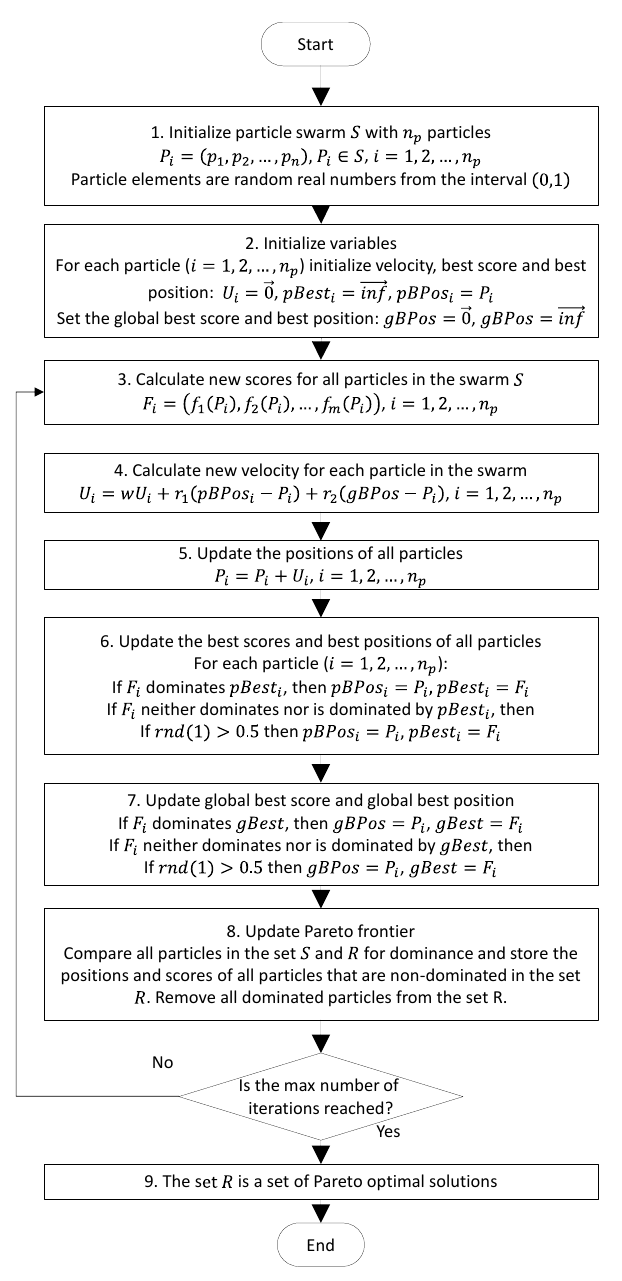
Figure 5. A flowchart of the multi-objective particle swarm optimization process for finding the set of Pareto optimal paths.